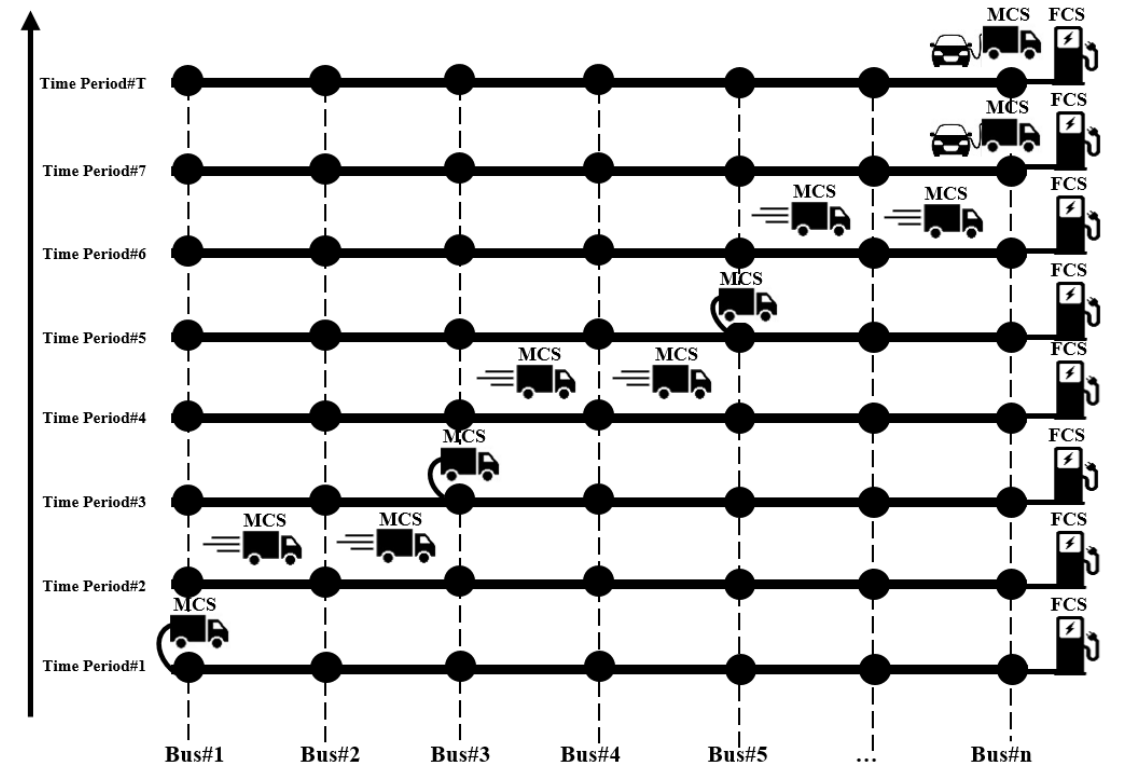
Figure 1. Spatio-temporal status of the mobile charging station.